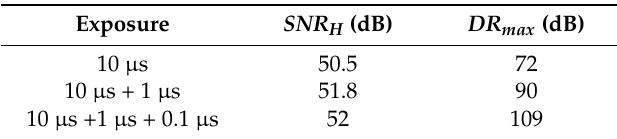
Table 1. Calculated SNR H and DR max from measured data for the cases of single, double and triple exposures with a ratio of 10 and K = 1.